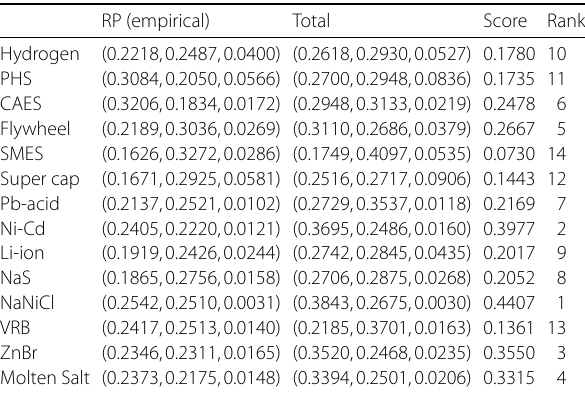
Table 8 The results of the evaluation of ESTs using the empirical reference point RP (empirical) Total Score